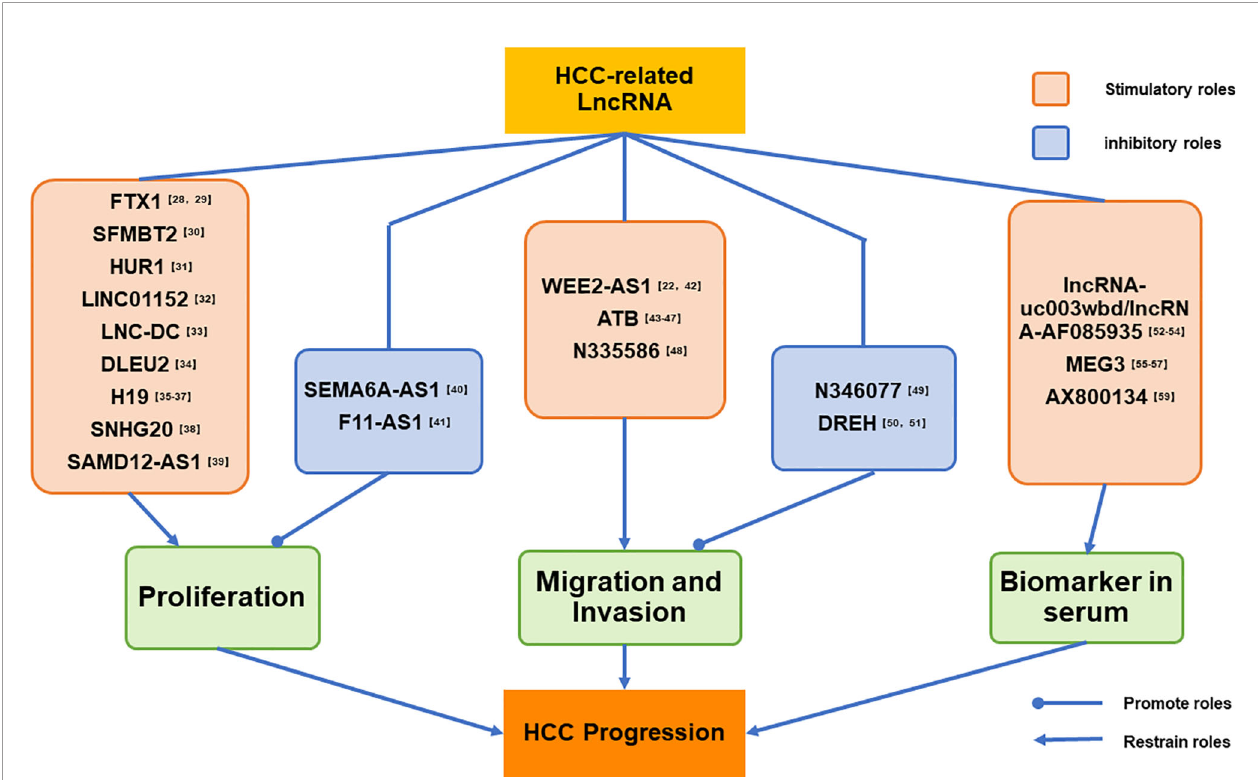
FIGURE 3 | HBV-encoded HBx protein inhibits expression of lncRNA F11-AS1. lncRNA F11-AS1 upregulates NR1I3 by binding to miR-211-5p. The downregulation of lncRNA F11-AS1 caused by HBx protein weakens its ability to bind to miR-211-5p, thus reducing expression of NR1I3. As a result, the proliferation, migration, and invasion of HBV-related HCC cells are enhanced, but apoptosis is decreased. It is important to note that lncRNA F11-AS1 may enhance expression of NR1I3 by acting as the ceRNA of miR-211-5p, ultimately hindering the development of HBV(+)